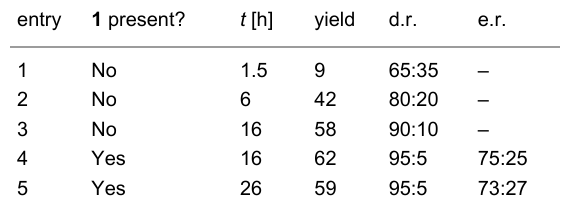
Table 2: Variation of yield and selectivity with quench time. entry